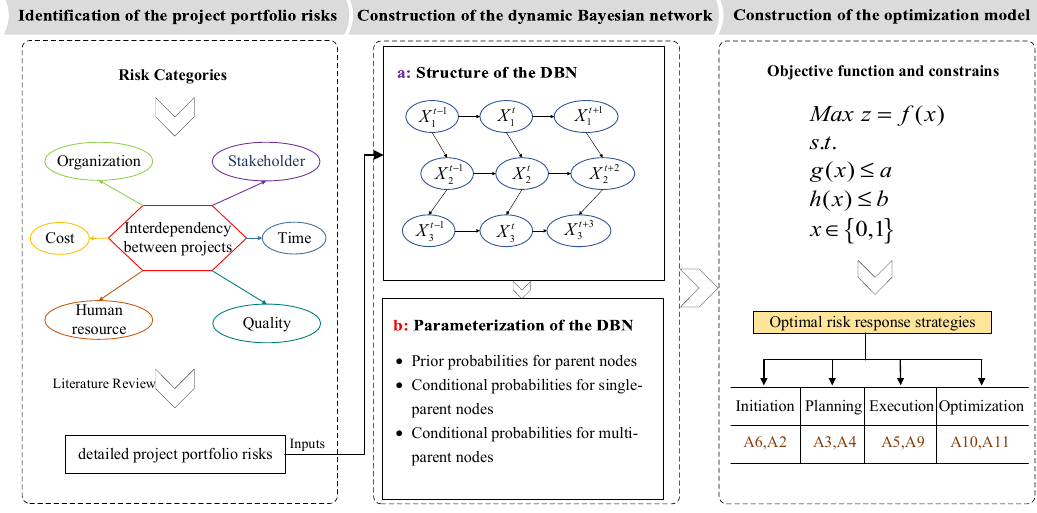
Figure 1. Proposed framework for the selection of risk response strategies.